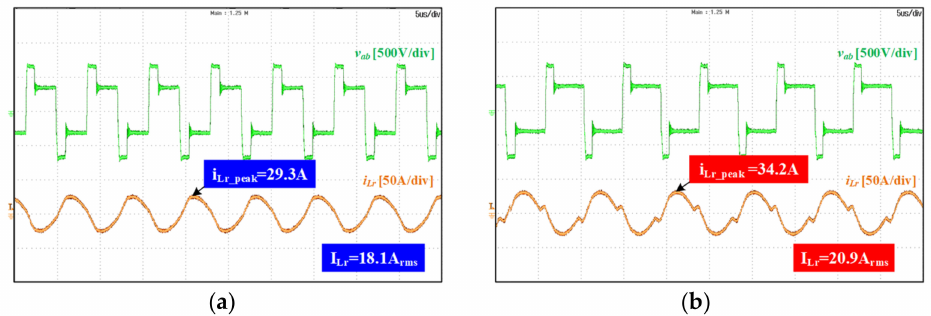
Figure 15. Experimental waveforms of the PWM control scheme: ( a ) proposed variable switching frequency; ( b ) conven- tional fixed switching frequency.